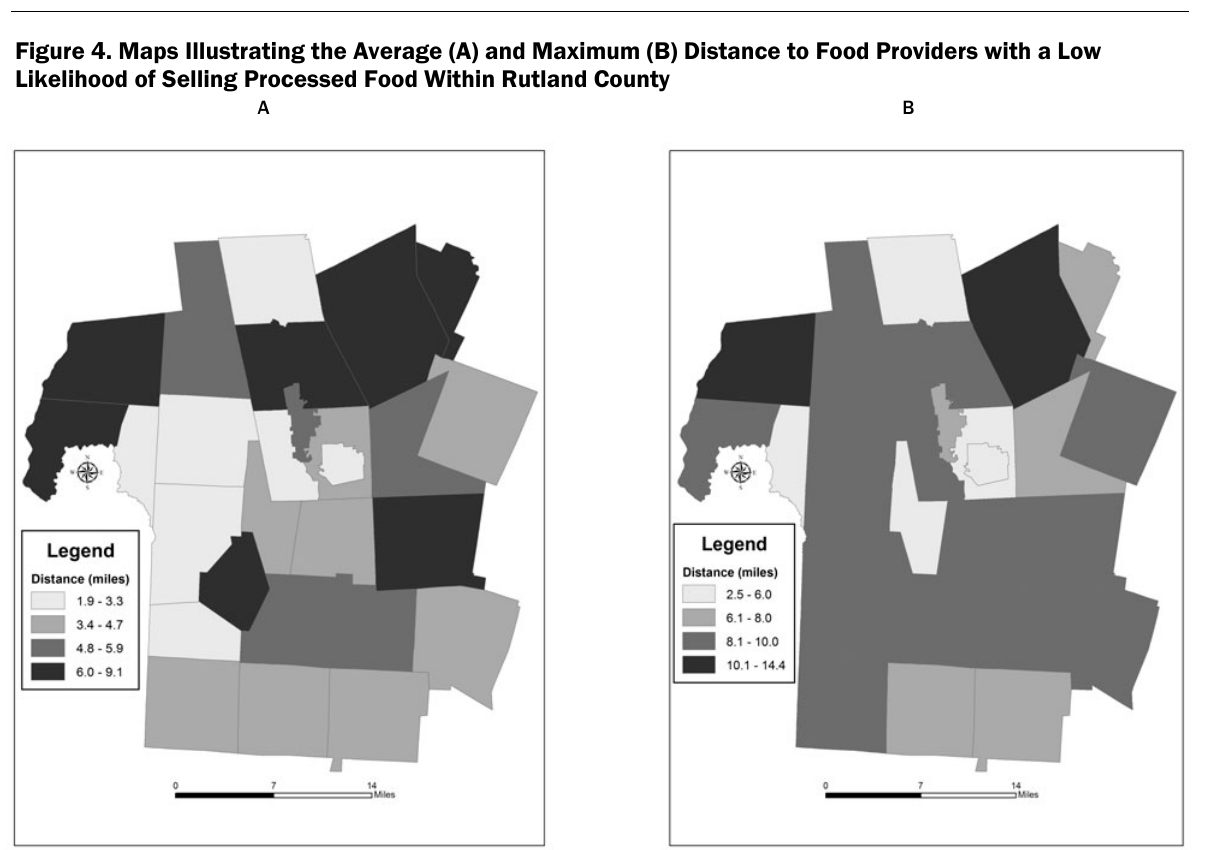
Figure 4. Maps Illustrating the Average (A) and Maximum (B) Distance to Food Providers with a Low Likelihood of Selling Processed Food Within Rutland County